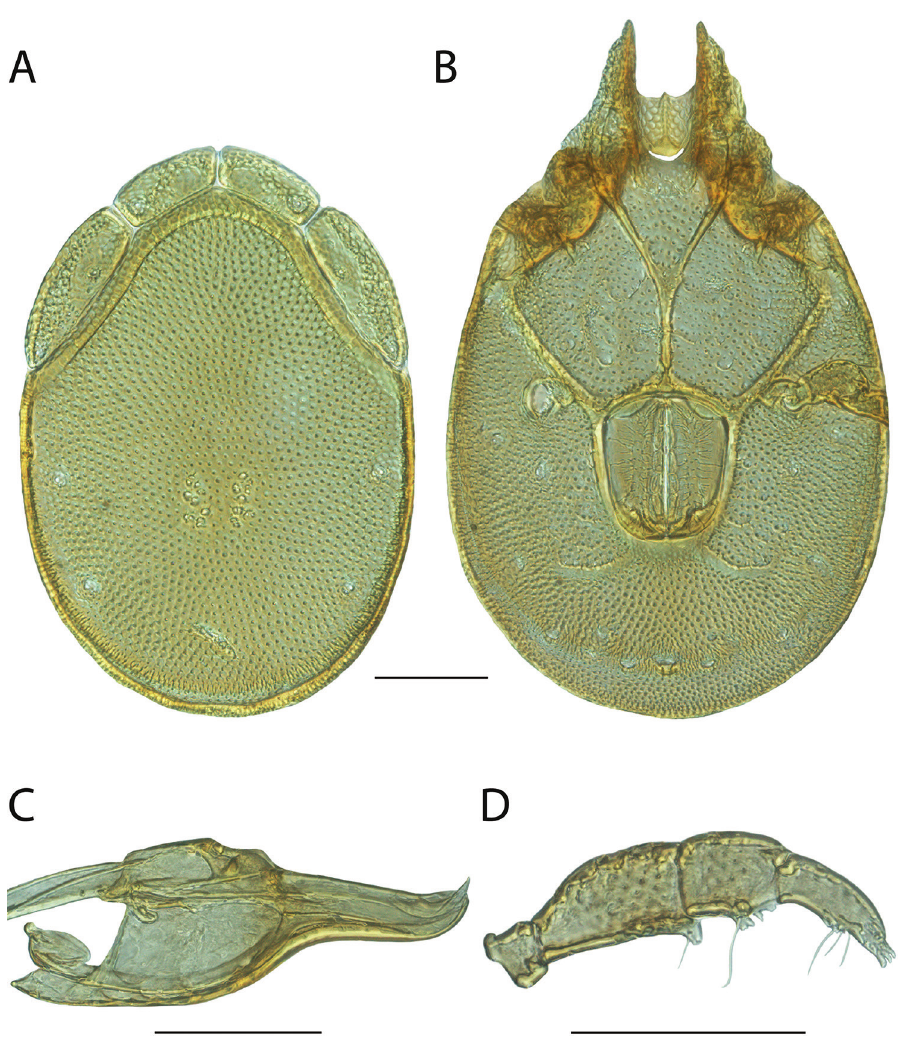
Figure 148. Torrenticola miniforma male: A dorsal plates B venter (legs removed) C subcapitulum D pe- dipalp (setae not accurately depicted). Scale = 100 m ale (Figure 148) (n = 1) (paralectotype only) with characters of the genus with following specifications.